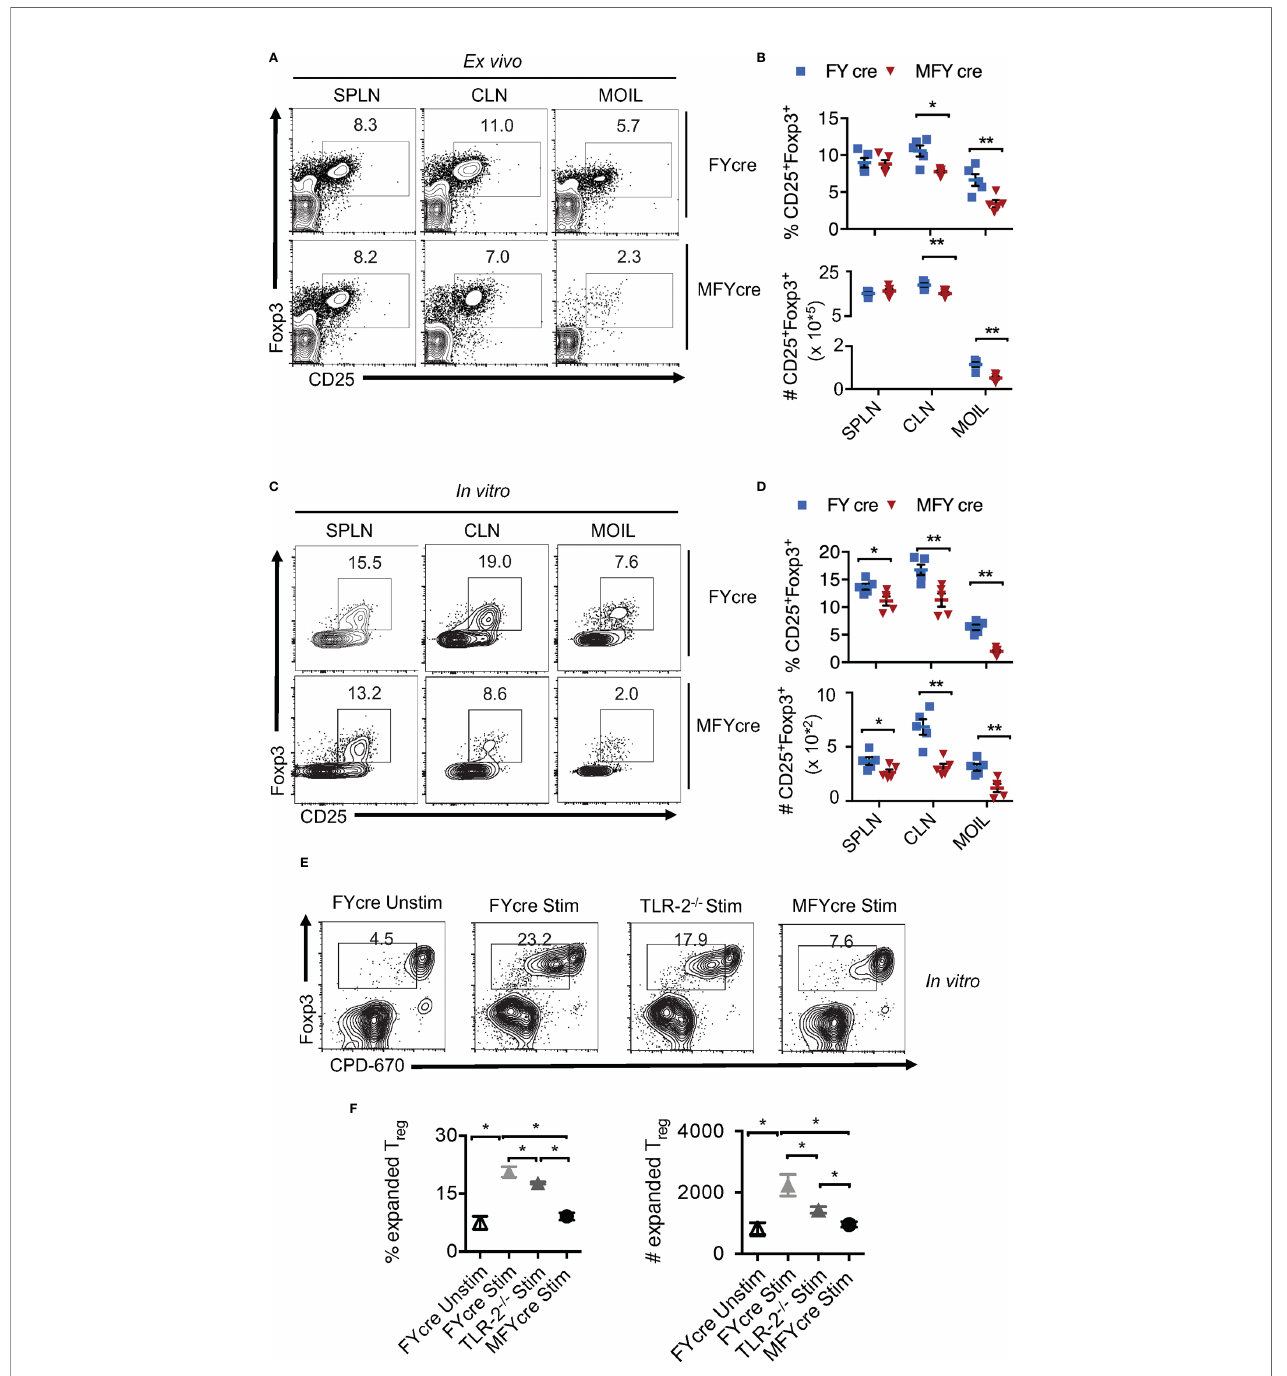
FIGURE 1 | MyD88 de fi ciency in Foxp3 + cells reduces oral mucosa T reg accumulation in vivo and during heat killed Candida albicans germ tube (HKGT) activation in vitro. Cells were isolated from spleen (SPLN) and cervical lymph nodes (CLN) and mouse oral intra-epithelial lamina propria leukocytes (MOIL) derived from FYcre and MFYcre mice. (A) Flow cytometric plots of CD25 and Foxp3 ex vivo . (B) Statistics of T reg frequency (above) and numbers (below) from individual mouse from FYcre and MFYcre groups ex vivo . (C) 3 x 10 5 cells from the indicated tissue were stimulated with a -CD3(1 m g/ml, a -CD28 (2 m g/ml), TGF- b 1 (5 ng/ml) and heat killed Candida albicans ( CA ) germ tube (HKGT) (10 7 /ml) for 5 days before assessing CD25 and Foxp3 by fl ow cytometry. (D) Statistics of CD25 + Foxp3 + cell frequency (above) and numbers (below) in cultures stimulated as in (C) , from indicated groups (Each data point corresponds to an individual mouse). (E, F) MyD88 signaling expands T regs . CLN CD4 + CD25 + Foxp3-YFP + T regs from FYcre and MFYcre mice, and CD4 + CD25 + T regs from TLR-2 -/- were FACS sorted and labelled with CPD-670. 5 x 10 4 T regs were stimulated with APC as in C . Flow cytometric plots showing CPD-670 dilution and Foxp3 (E) , and statistics showing T reg expansion (F) are depicted. Mean values ± SEM are plotted. (*P < 0.05; Mann Whitney test). Data represent at least triplicate experiments. **P <